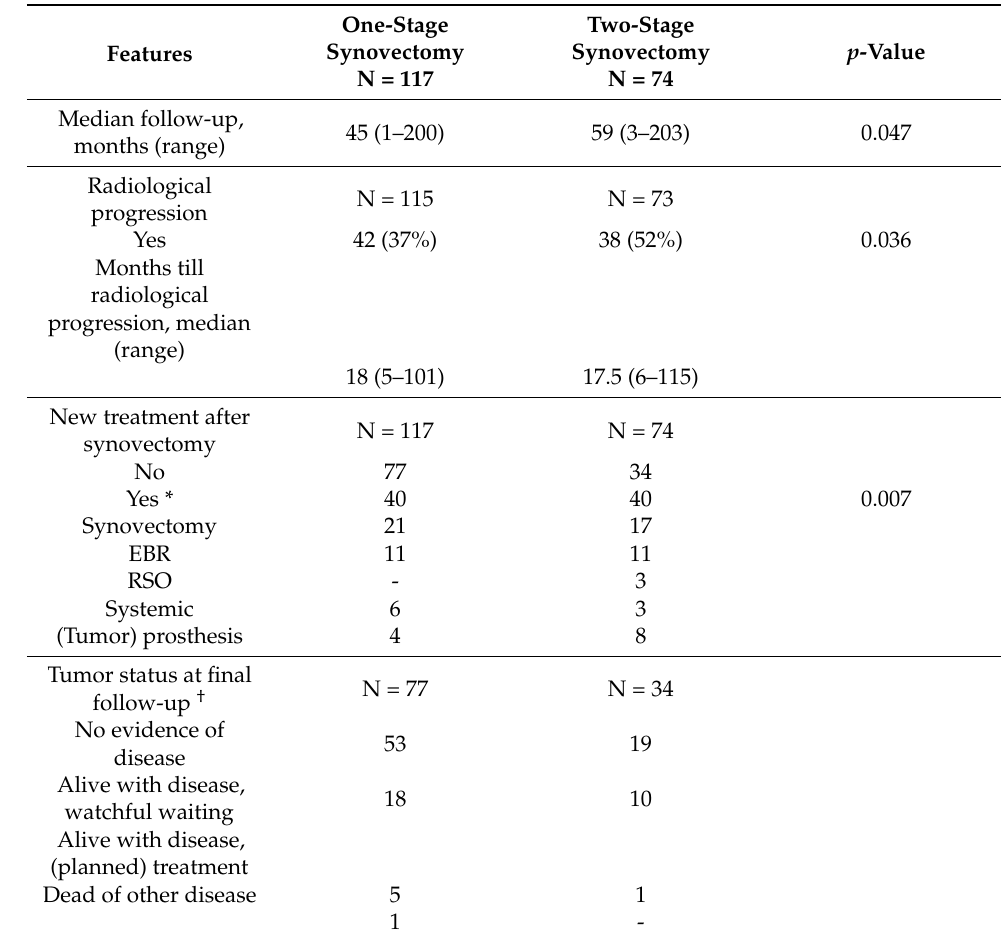
Figure 2. Course of the postoperative flexion range. Table 3. Postoperative